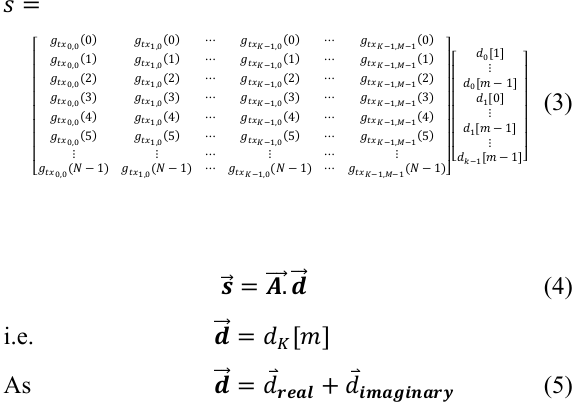
TABLE 1: Table of Notations [𝒎] Pulse shaped data 𝒅 𝒌 𝑨⃗⃗ Matrix form of A 𝒅⃗⃗ Data vector 𝒅⃗⃗ 𝒓𝒆𝒂𝒍 𝒅⃗⃗ 𝒊𝒎𝒂𝒈 𝒔⃗ 𝒊𝒎𝒂𝒈 𝒔⃗ 𝒓𝒆𝒂𝒍